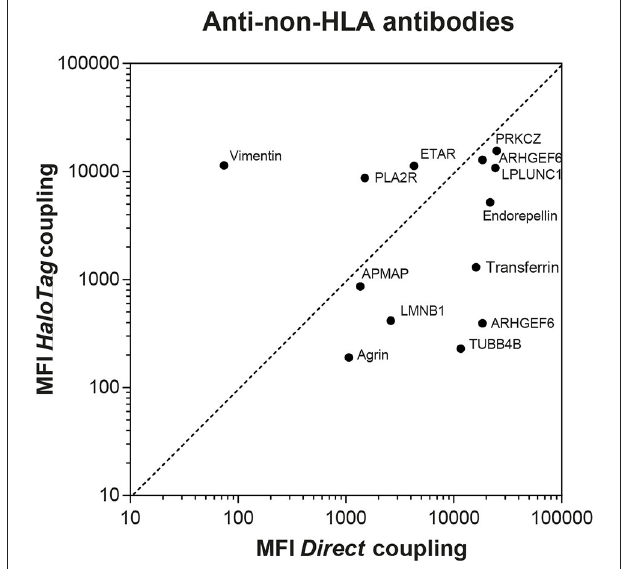
FIGURE 1 | Comparison between directly and HaloTag coupled microspheres after incubation with commercially available animal anti-non-HLA antibodies. For AT1R and PECR only microspheres with direct coupling were available, therefore the comparison with HaloTag coupled microspheres cannot be depicted. The MFI measured after incubation of the AT1R microspheres with the anti-AT1R antibody was 13,760 and 18,842 for the PECR microspheres after incubation with the anti-PECR